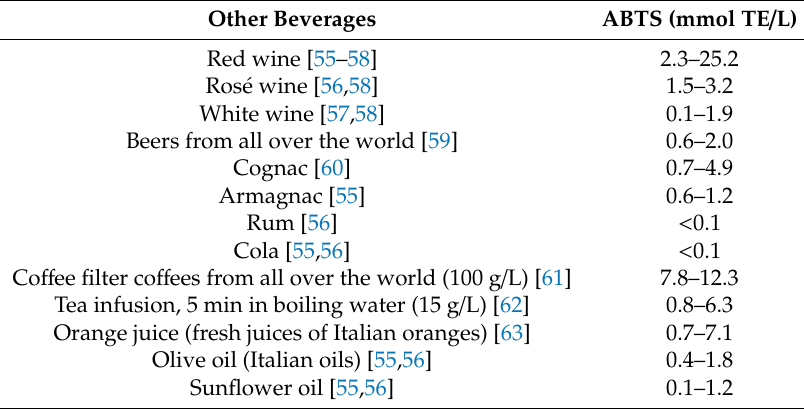
Table 8. Capacity of several alcoholic and non-alcoholic